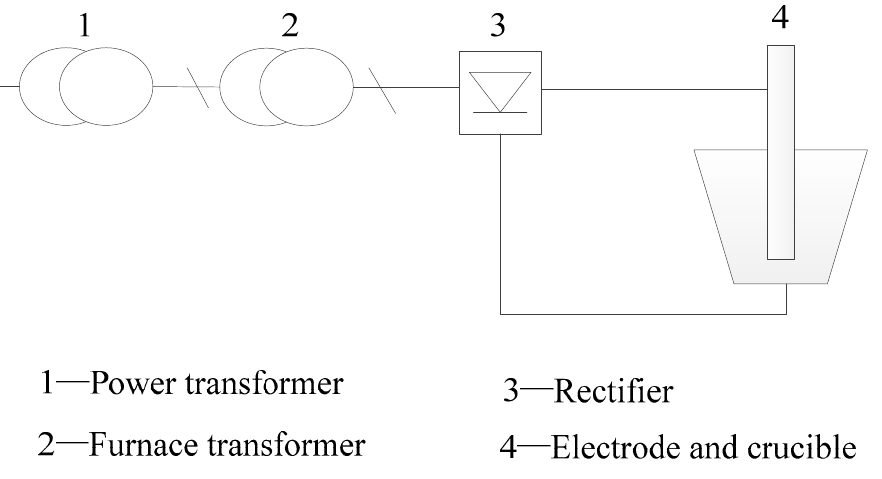
Figure 1. Schematic diagram of the electric arc furnace system structure.